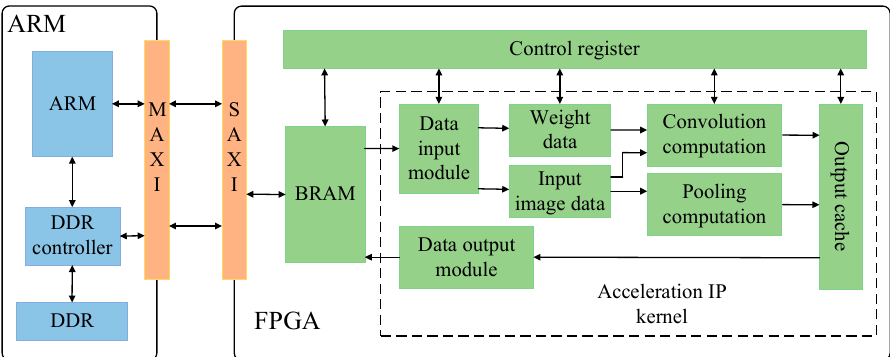
Figure 10. Overall system structure of FPGA implementation.